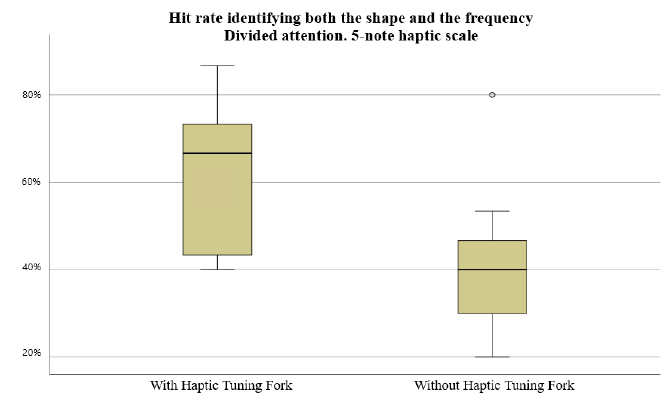
( b ) Box plot for the hit rate regarding the identification of both the shape and the frequency. Figure 6. Experiment B